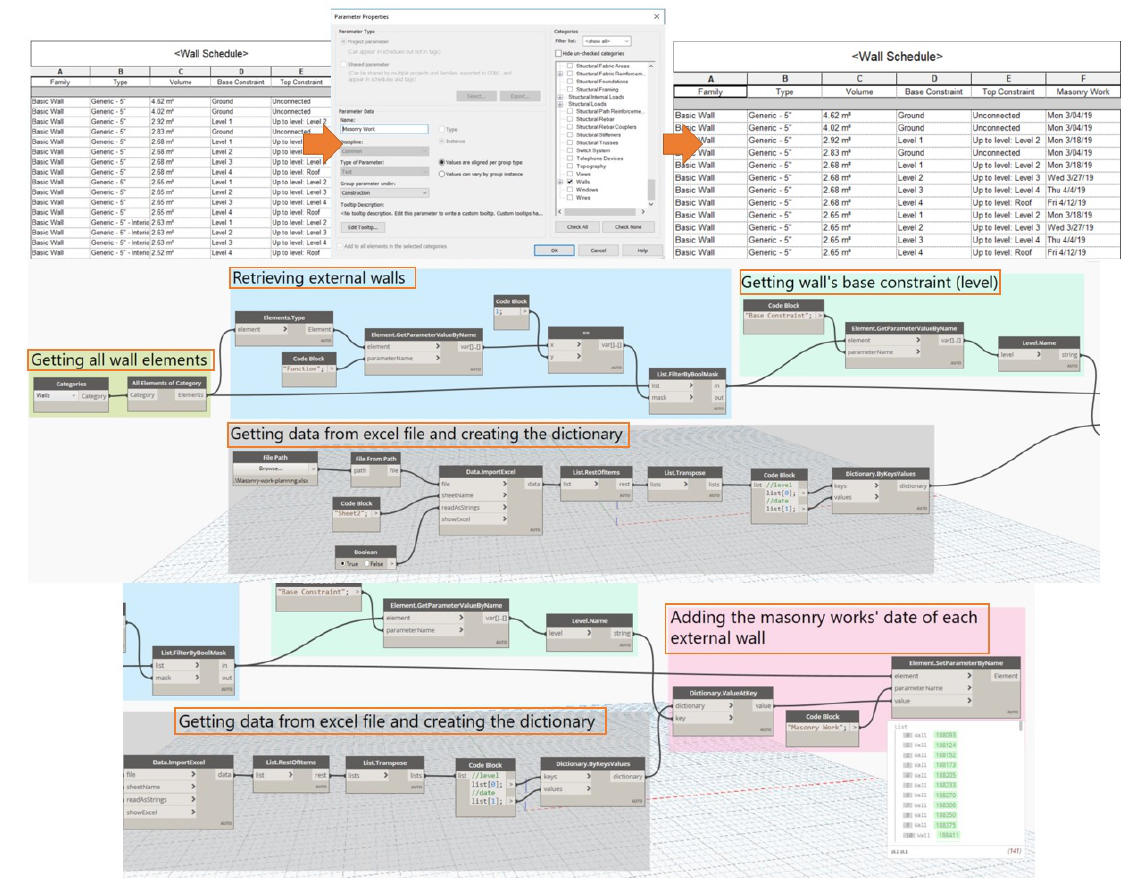
Figure 10. Wall schedule